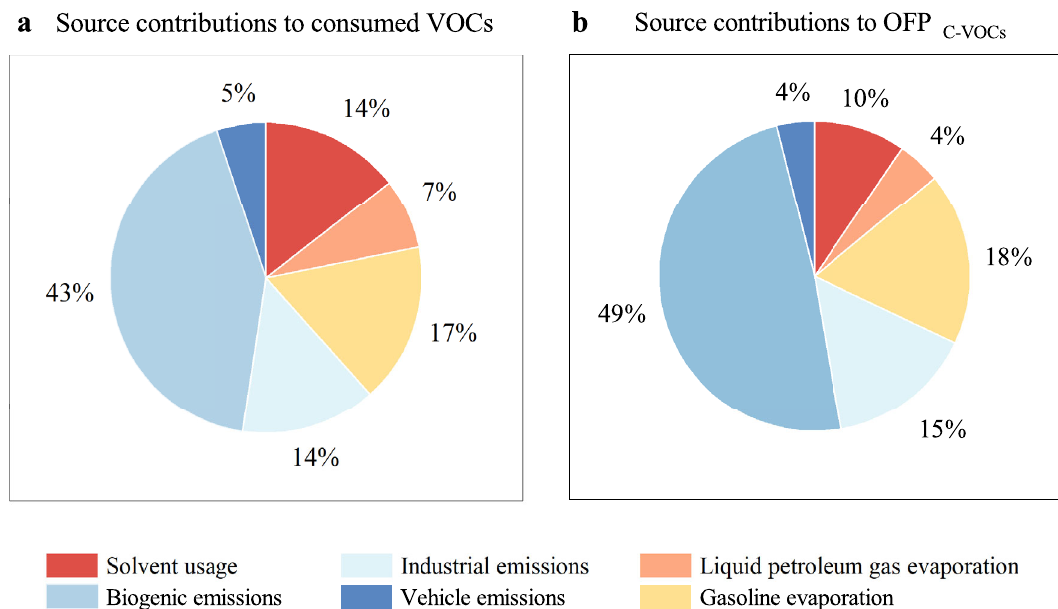
Fig. 5 The main source contributions to VOCs and their potential impacts on O 3 formation. a Source apportionment to consumed VOCs (C- VOCs); and b contributions of different pollution sources to OFP C-VOCs (based on nine reactive species). The highest contributor to C-VOCs is different from the highest contributors to M-VOCs and In-VOCs (Supplementary Fig. 8). This fi gure shows that focusing on the sources of C-VOCs can capture the real source of VOCs ’ effect on O 3